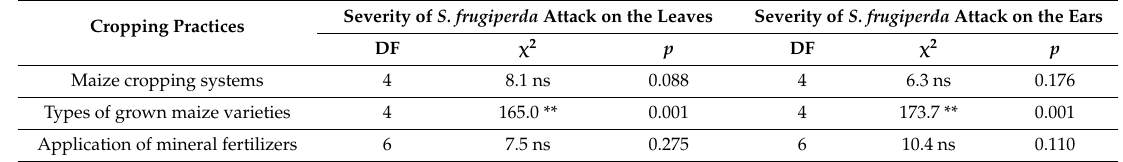
Table 7. Chi-square test analysis of the relationship between cropping practices and the severity of S. frugiperda